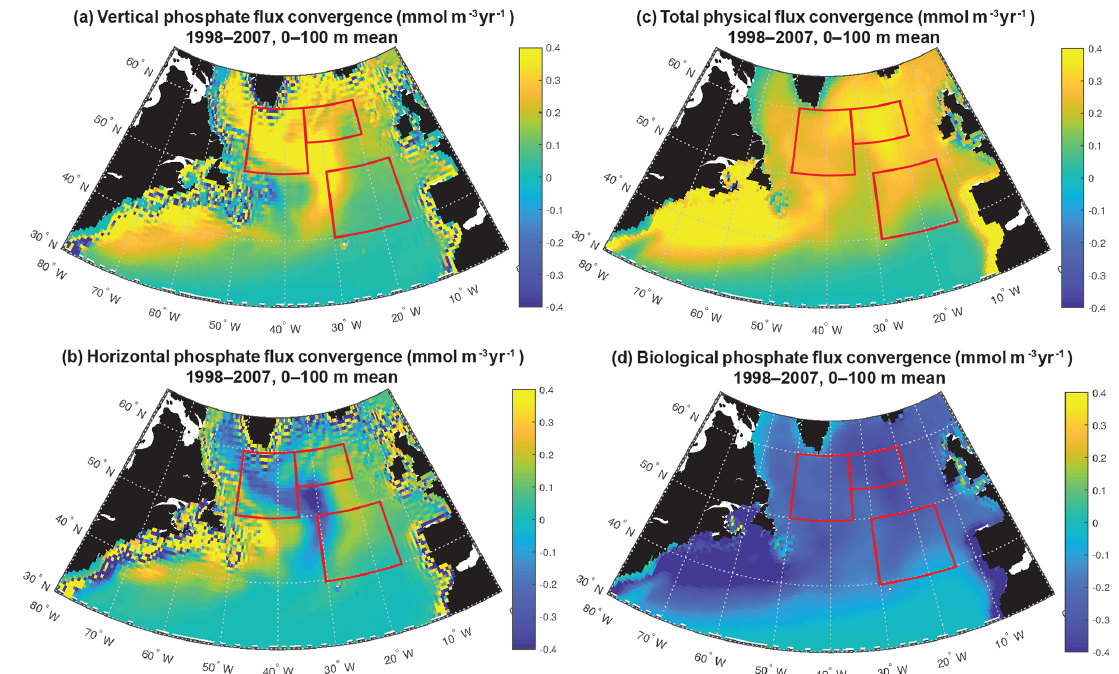
Figure 8. Phosphate diagnostics: (a) vertical, (b) horizontal, (c) net physical and (d) biological flux convergence (mmolm − 3 yr − 1 ) averaged over 0–100m. Biological is negative because biomass removes phosphate from the surface ocean. The three focus regions are outlined in red in each